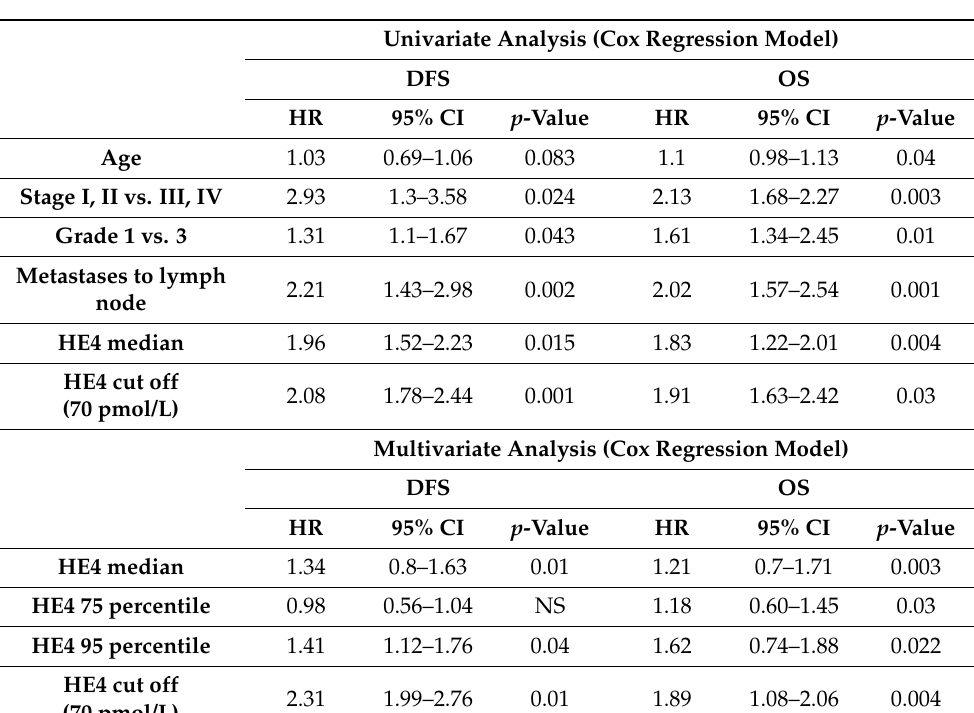
Table 5. Cox regression analyses of the disease-free survival and overall survival of classic prognostic factors and HE4.